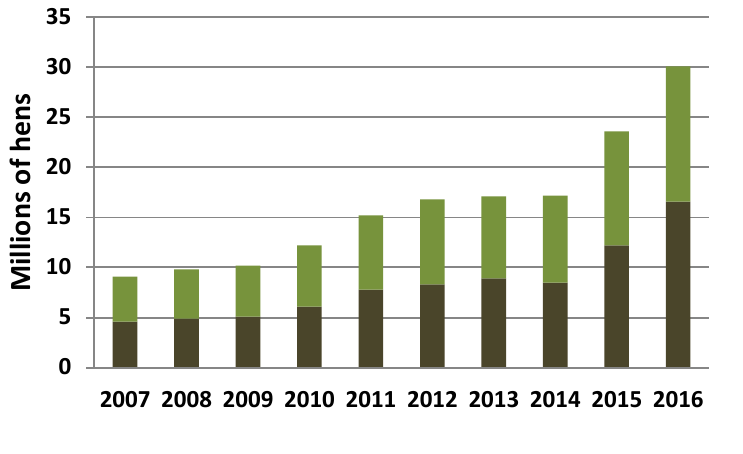
Figure 1. Percent cage-free egg production in the United States.